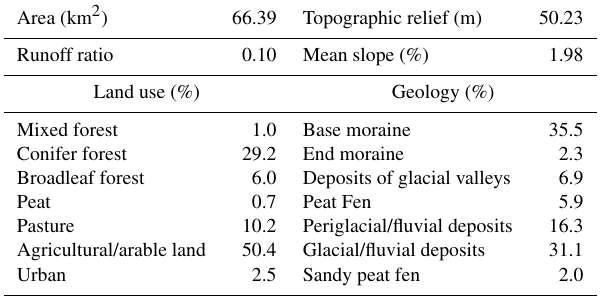
Table 1. Overview of the properties of the Demnitzer Mill Creek catchment at the catchment outlet. The overview includes physio- logical characteristics, land use, and